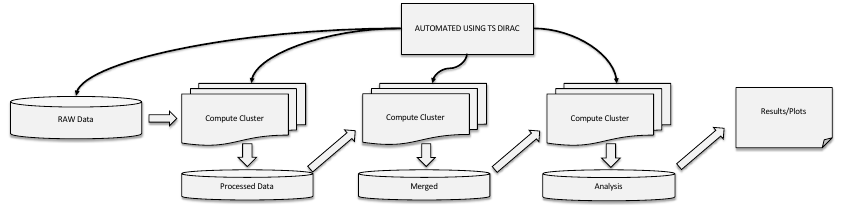
Figure 3. Project 8 automated data processing